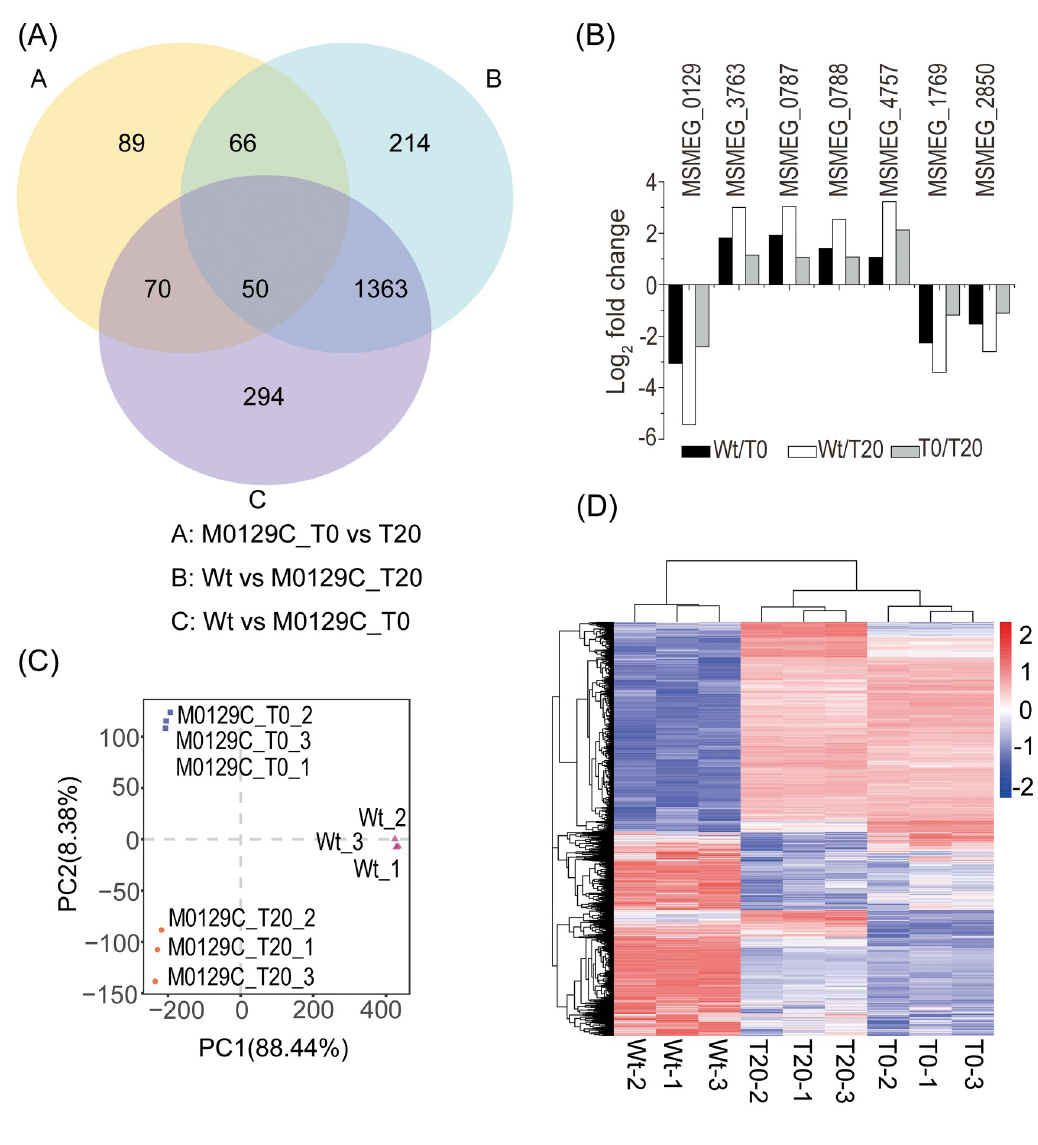
Fig 1. Differentially expressed genes in pair-wise comparisons. (A) Venn diagram showing the numbers of significantly differentially expressed genes (fold change > 2, adjusted p-value < 0.05). (B) Differentially-expressed genes that show similar fold change trends. (C) Principal component analysis of the global expression patterns of the 3 samples. (D) Hierarchical clustering of the 2146 differentially expressed genes (adjusted p-value < 0.05).